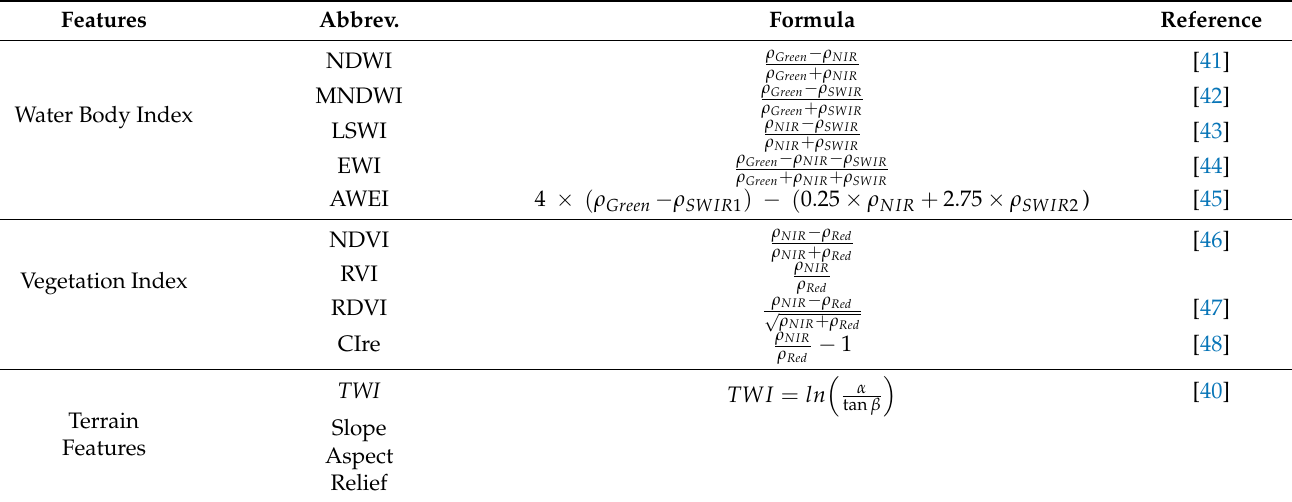
Table 3. Formulates and sources of feature